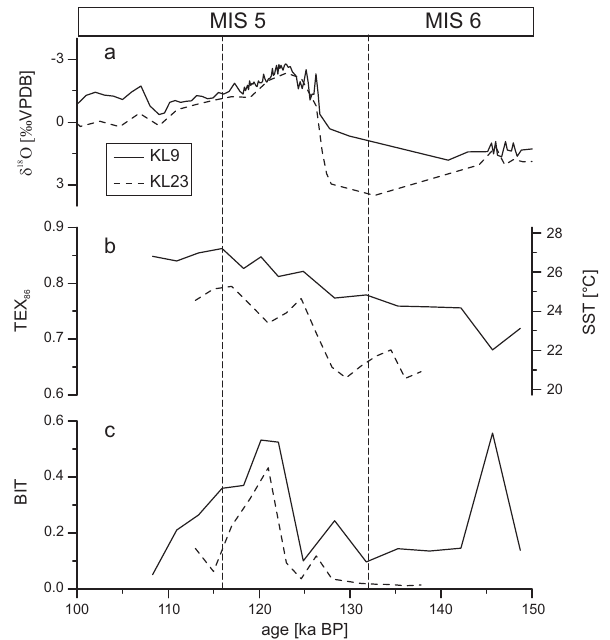
Fig. 6. Geochemical data of cores KL9 and KL23: (a) oxygen iso- topes (KL23 (Geiselhart, 1998) and KL9 (Rohling et al., 2008b)), (b) TEX 86 (SST scale is only valid for KL23, see discussion in Sect. 4.1, and (c) BIT values. Dashed vertical lines mark MIS-